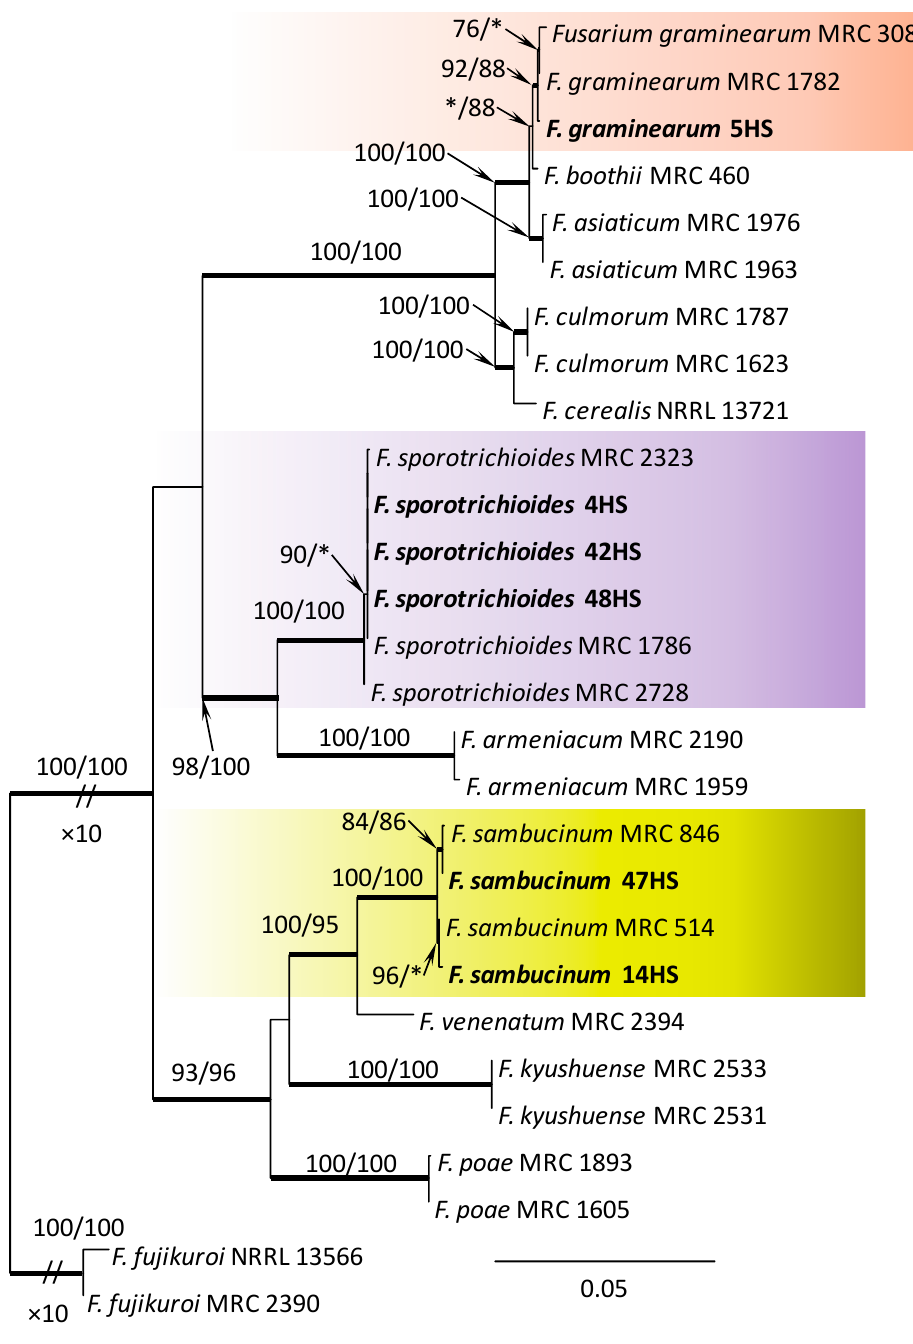
Figure 3. Phylogram obtained from Maximum Likelihood (ML) analysis of the combined dataset of RPB2 + TEF1- α for selected species of the Fusarium sambucinum SC. Sequences obtained during this study are presented in bold font. The Bootstrap values ≥ 75% for ML and Maximum Parsimony (MP) analyses are presented at nodes as follows: ML/MP. Bold branches indicate posterior probabilities values ≥ 0.95 obtained from Bayesian Inference (BI) analyses. * Bootstrap values <75%. The tree is drawn to scale (see bar) with branch length measured in the number of substitutions per site. Fusarium fujikuroi represents the outgroup in the analysis of the combined dataset of RPB2 + TEF1- α .